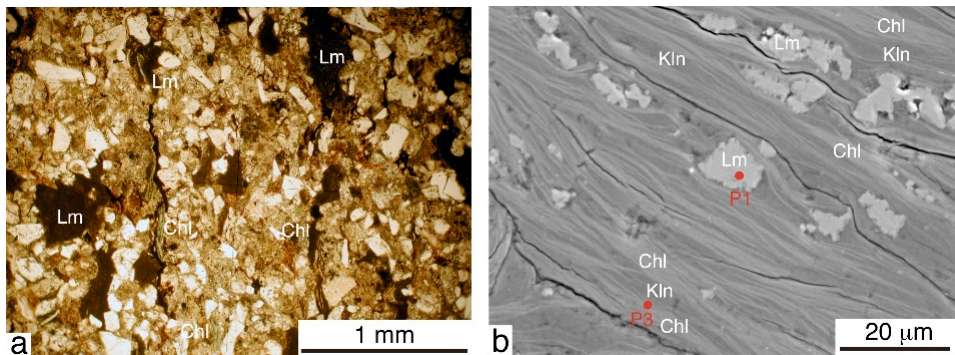
Figure 8. Microphotograph of phyllosilicate bands in outcrop sample KT3. See Figure 1b for the locality. ( a ) Phyllosilicate bands (plane-polarized light). Note that chlorite and iron oxide or hydroxide (probably limonite) grains aligned parallel to the bedding plane (the short dimension of the microphotograph) ( b ) SEM-BSE microphotograph of altered chlorite grains aligned parallel to the phyllosilicate bands, including limonite grains. Measurements points for microchemical analysis with SEM-EDS and EPMA are indicated by filled red circles. The measurement points P2 and P4 are outside of the view. See Table 3 for the compositions. Chl, chlorite; Lm, limonite; Kln, kaolinite.